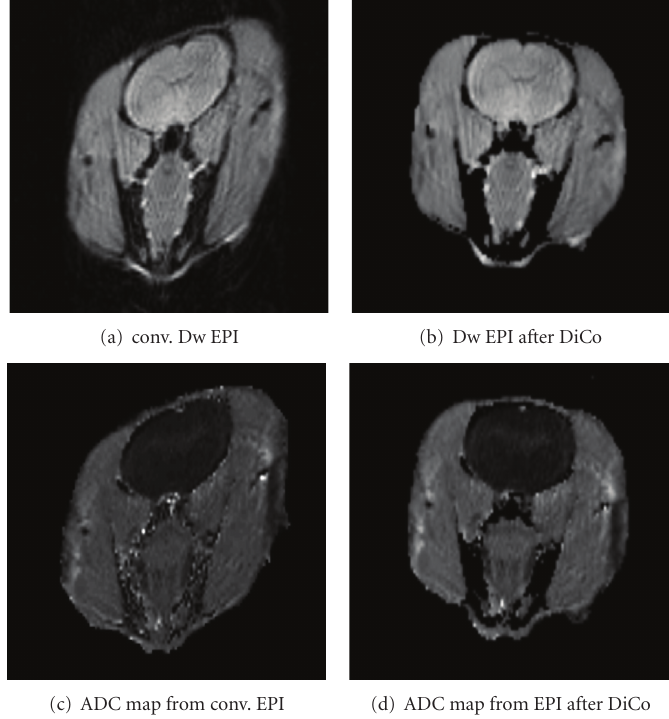
Figure 5: Example of di ff usion weighted image acquisition in a rat. A 4-shot di ff usion weighted SE-EPI was used for data acquisition. (a) Original SE-EPI and (b) SE-EPI after DiCo. ADC maps were calculated from original and corrected SE-EPI and are given in (c) and (d). In the SE-EPI (b) and corresponding ADC map (d) a significant improvement in geometric representation can be